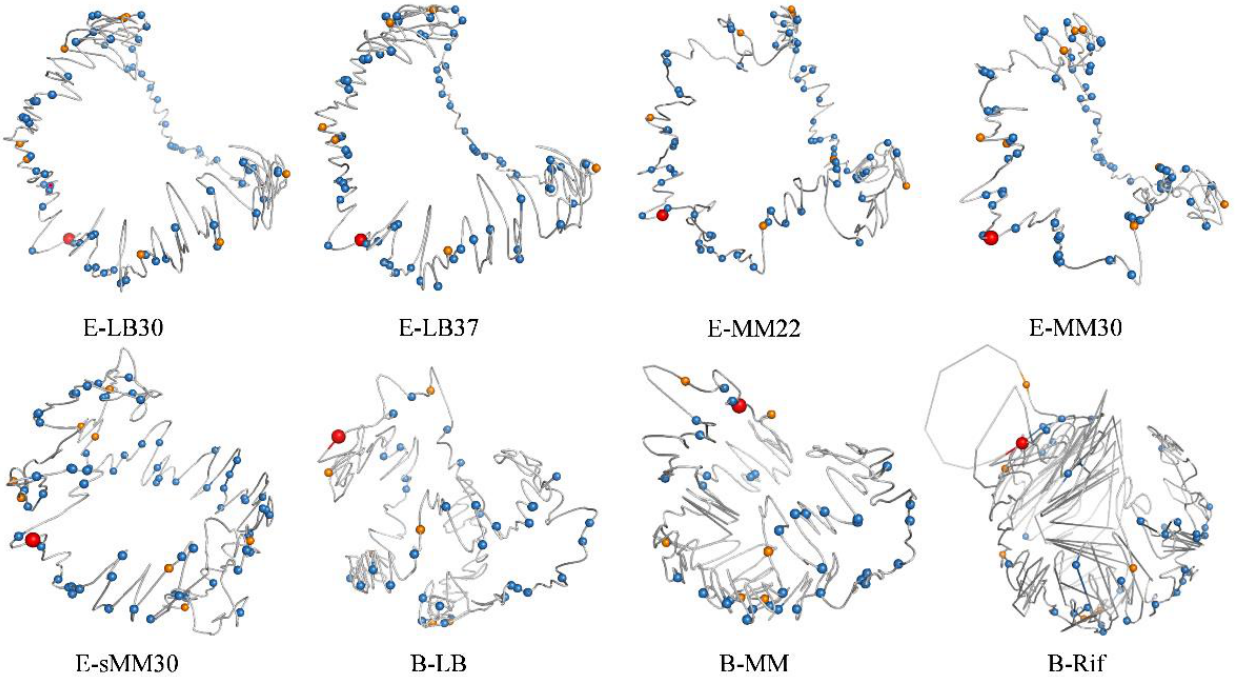
Figure 6. The distribution of high-level regulatory genes in the 3D architecture of bacterial chromo- somes. In the 3D models of E. coli and B. subtilis chromosomes, the genes of the top (orange) and middle (blue) layers in the TRN hierarchy are shown as spheres, and the bigger red balls indicate the positions of oriC loci. The E. coli chromosome resembles a letter C, and the top-layer genes (orange) are mainly distributed at both ends of the letter C. The B. subtilis chromosome is spiral-shaped, and the top-layer genes (orange) are mainly distributed in the middle and one end of the spiral. The middle-layer genes (blue) seem evenly distributed in the 3D architecture.